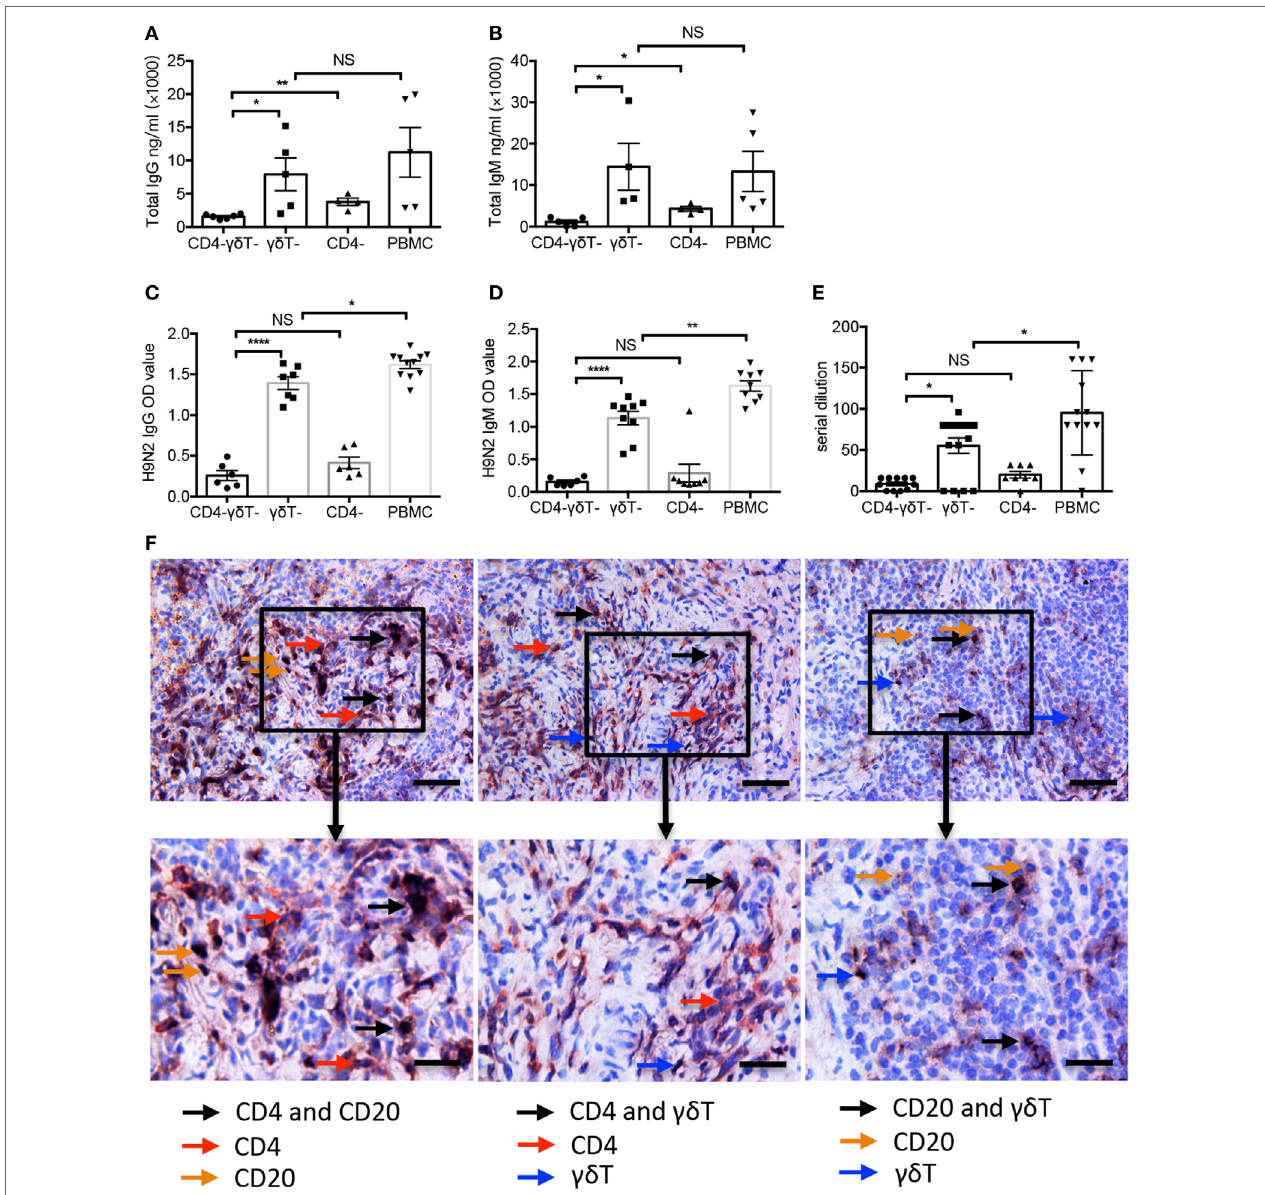
FigUre 6 | V γ 9V δ 2-T cells increased H9N2 virus-specific IgG and IgM productions in vivo . Specific immune cells-depleted and whole peripheral blood mononuclear cells (PBMC)-humanized mice were vaccinated with UV-inactivated H9N2 virus through i.p. pathway on day 0 and 7. Serum was collected on day 21 post the first vaccination. (a,B) Total IgG and IgM in serum (c,D) H9N2 virus-specific IgG and IgM in serum that treated with receptor destroyed enzyme (RDE) were determined by enzyme-linked immunosorbent assay. (e) H9N2-specific antibodies in serum that treated with RDE were determined by hemagglutination inhibition assay. The data shown were the represent of four independent experiments. (F) Representative histological analysis, immunohistological stainings for human CD4 T, B, and γδ -T cells in formalin-fixed paraffin-embedded spleen in humanized mice constructed with whole PBMCs after UV-H9N2 virus immunization. Scale bars = 100 μ m. Bottom panels showed the higher-magnification views of the respective boxed areas in the top panels. Scale bars = 50 μ m. The data shown are the mean ± SEM. * p < 0.05; ** p < 0.01; *** p < 0.001. NS, no significant